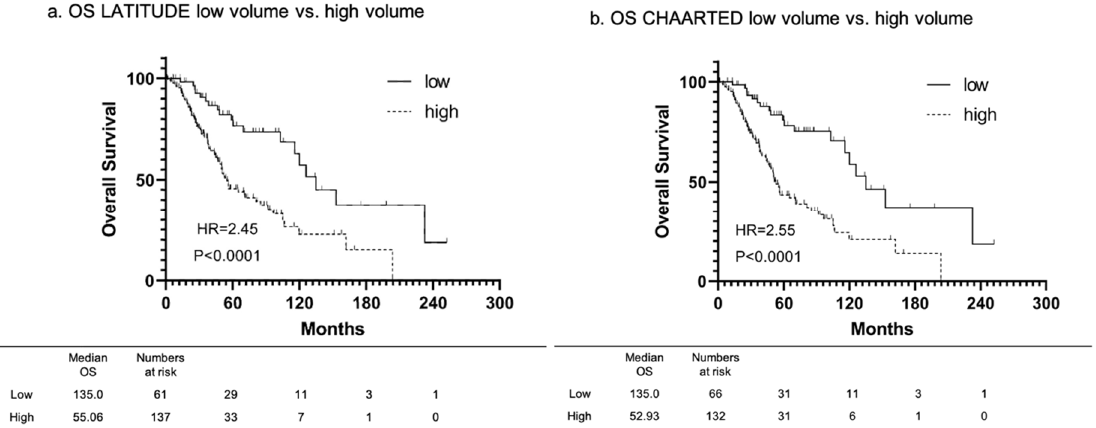
Figure 1. Kaplan-Meier showing the difference in OS classified by LATITUDE criteria, and CHAARTED criteria. ( a ) The high-risk group had a significantly shorter OS (HR: 2.45, 95%